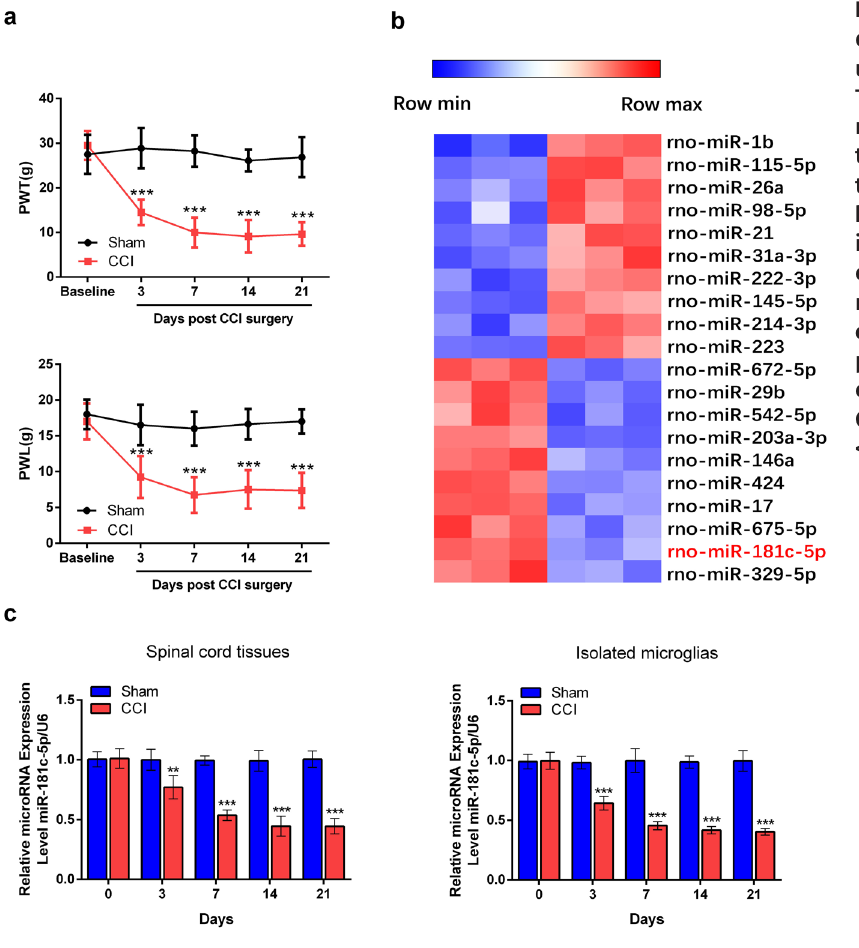
Figure 1. miR-181c was dysregulation in spinal cord under NP conditions. a. The effect of CCI surgery on mechanical allodynia and thermal hyperalgesia was tested at day 0, 3, 7, 14, 21. b. Hierarchical clustering image was generated to exhibit expression level of miRNAs after CCI surgery. c. RT-PCR analysis was performed to examine the expression of miR-181c after CCI surgery. **P < 0.01 , ***P < 0.001 vs . Sham